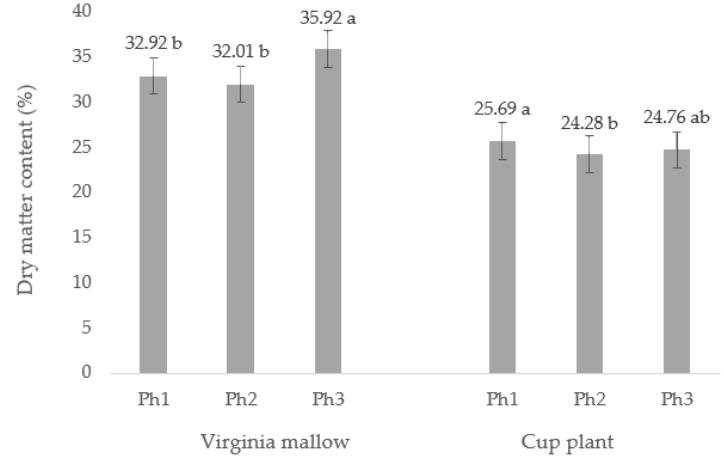
Table 6. Plant sampling dates for analysis of bioactive compounds.